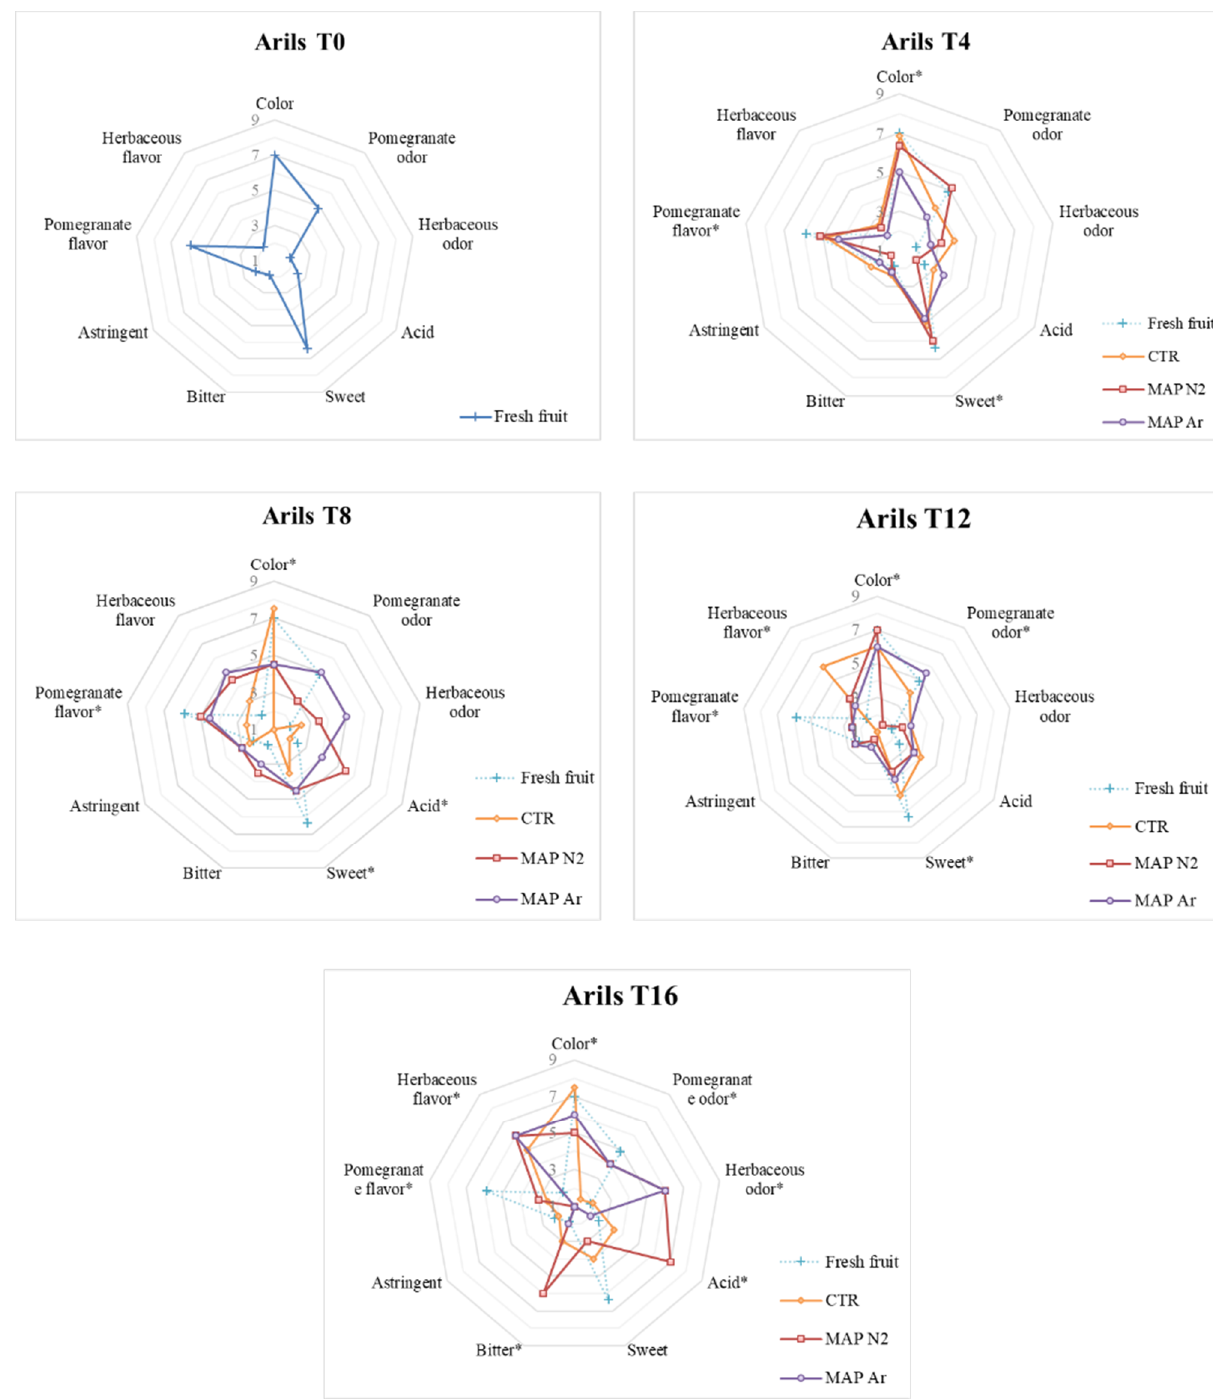
Figure 5. Sensory analysis performed on the arils treated with MAP (CTR: 20.9% O 2 + 0.04% CO 2 (passive-MAP); MAPN2: 10% O 2 + 5% CO 2 + 85% N2; MAPAr: 10% O 2 + 5% CO 2 + 85% Ar). Analyses were carried out after storage for 0 (T 0 ), 4 (T 4 ), 8 (T 8 ), 12 (T 12 ), and 16 (T 16 ) days at 4 ± 1 °C and 90 ± 5% RH. Scores of the fresh fruit, marked with +, are shown at all evaluation times for reference purpose. * indicates the presence of significant differences between treatments at the same analysis time.